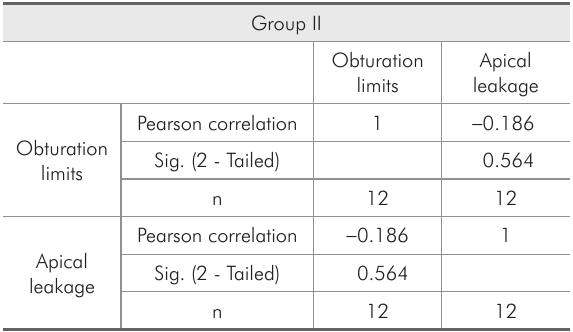
Table 2 - Correlation analysis of Group